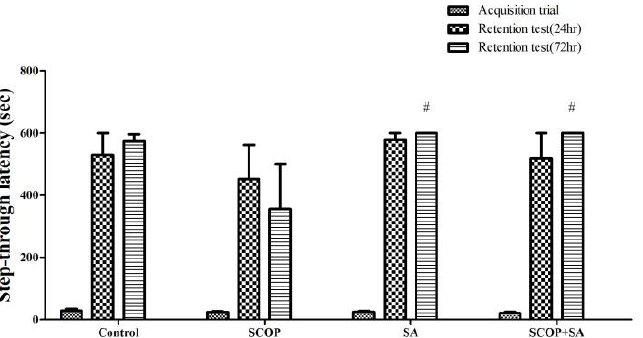
Figure 5. The effect of SA on long-term avoidance memory in SCOP-treated. Step-through latency was measured in the acquisition trial, retention at 24 h and retention at 72 h in the PA test. During the acquisition trial, an electric foot shock was delivered. n = 4. # p < 0.05 vs. the SCOP group at 72 h. Data were analyzed by one-way ANOVA with LSD test.